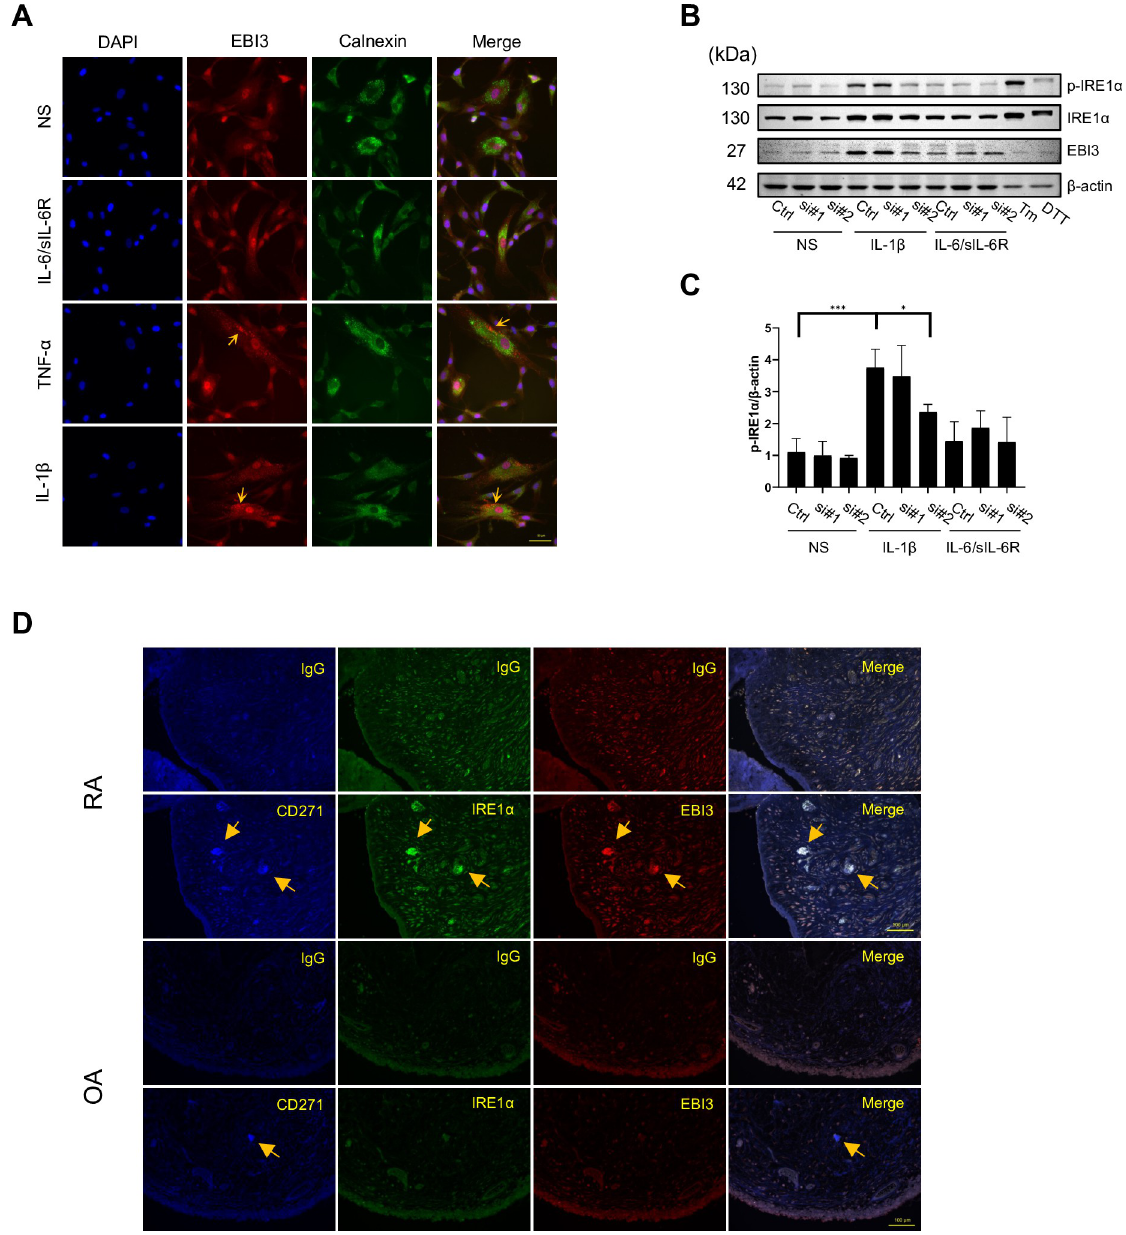
Fig 5. EBI3 proteins localize in the ER of MSCs and modulate IRE1 α under inflammatory conditions. (A-C) MSCs were cultured in a monolayer in growth medium. (A) Human MSCs were stimulated with IL-6/sIL-6R (100 ng/ml), TNF- α (100 ng/ml) or IL-1 β (3 ng/ml). The immunocytochemistry detected EBI3 and Calnexin. Nucleus was stained by DAPI (5 μ g/ml). Images are representative of 3 independent experiments with similar findings. Scale bar, 50 μ m. (B) Human MSCs were transfected with control siRNA or 2 different EBI3 siRNAs (si#1 and si#2) for 48 hrs. After that growth medium was refreshed, IL-1 β and IL-6/sIL-6R were then added for 36 hrs. MSCs treated with Tunicamycin (Tm) and DTT were used as positive control of ER stress. Whole-cell lysates were analyzed for each ER stress sensors and EBI3 by Western blotting. (C) Densitometric analysis of the Western blotting in B was performed, and the data were normalized to β -actin. Quantified data are expressed as the mean ± SD (each n = 3). � = P < 0.05; ��� = P < 0.001 by Dunnett’s multiple comparison test. (D) Synovial specimens from RA patients (n = 3) and OA patients (n = 3) were stained by immunofluorescence using specific antibodies against CD271, EBI3, and IRE1 α . Results are representative of 3 independent experiments with similar findings. Scale bar, 100 μ m.